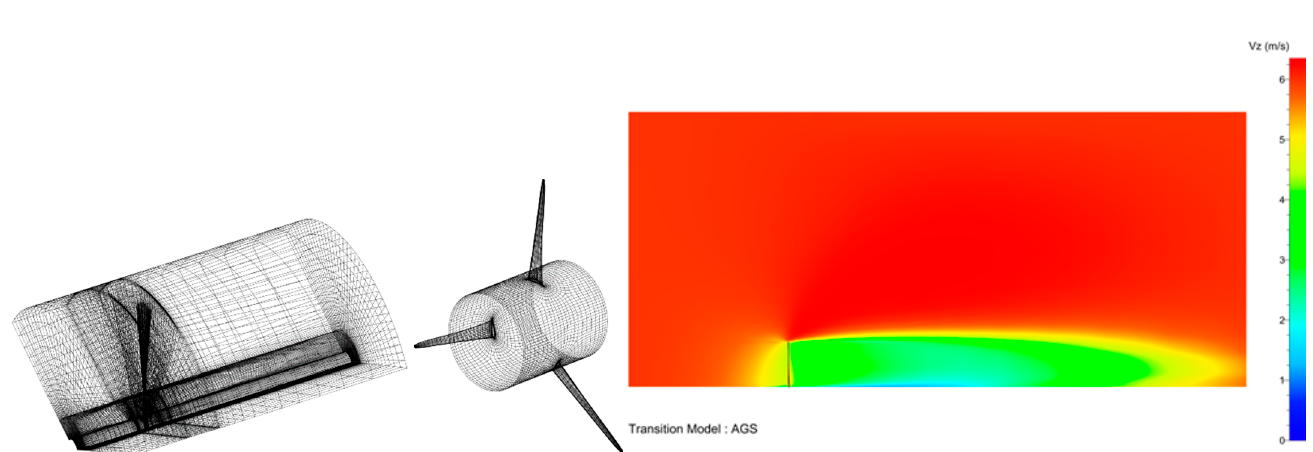
Figure 34. Periodic 3D mesh and blade mesh for HKT with axial velocity axisymmetric contour. There is no inlet nor outlet boundary condition (BC) defined for unducted rotors.